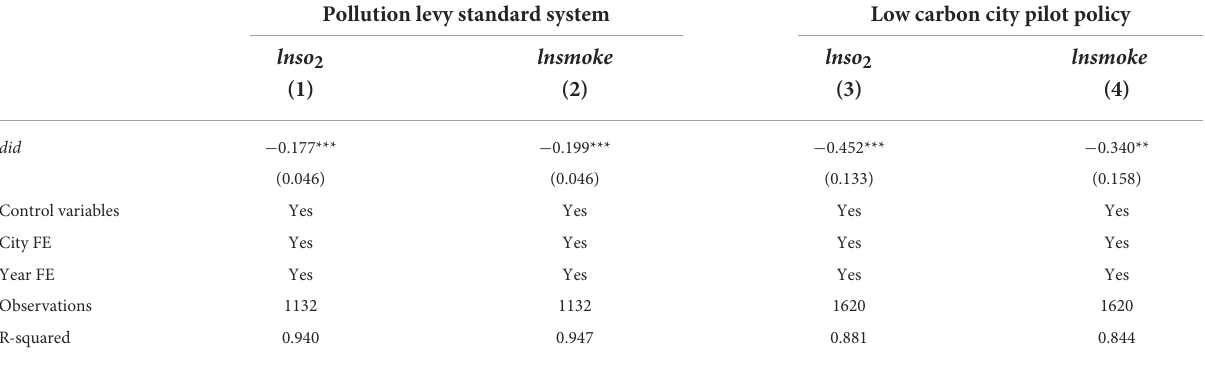
TABLE 3 Effects of policy uniqueness